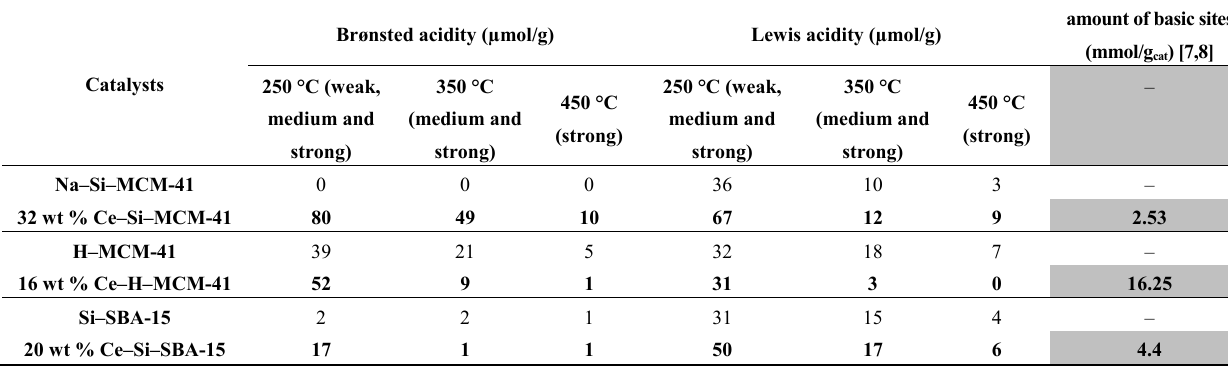
Table 1. Brønsted and Lewis acidities of Ce modified